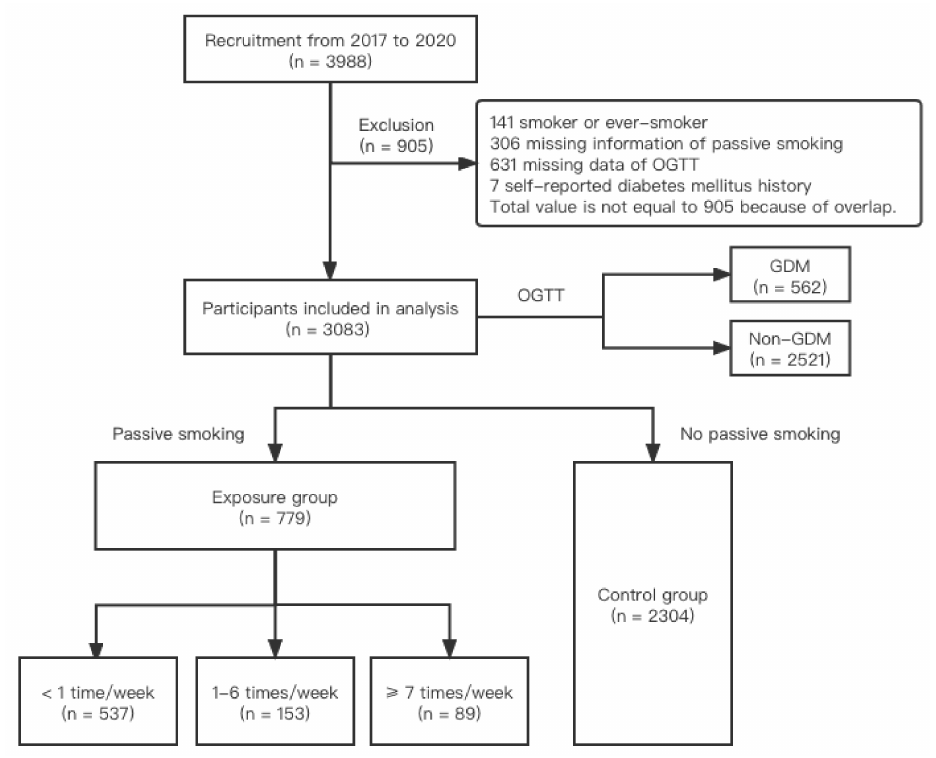
Figure 1. Flowchart of recruitment and